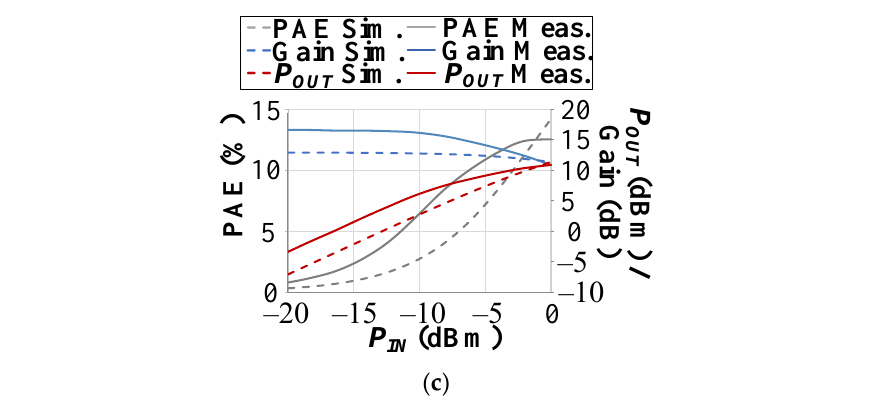
Figure 14. Measured maximum PAE, S 21 , and P OUT,SAT vs. frequency of the broadband CMOS FD- SOI PA.